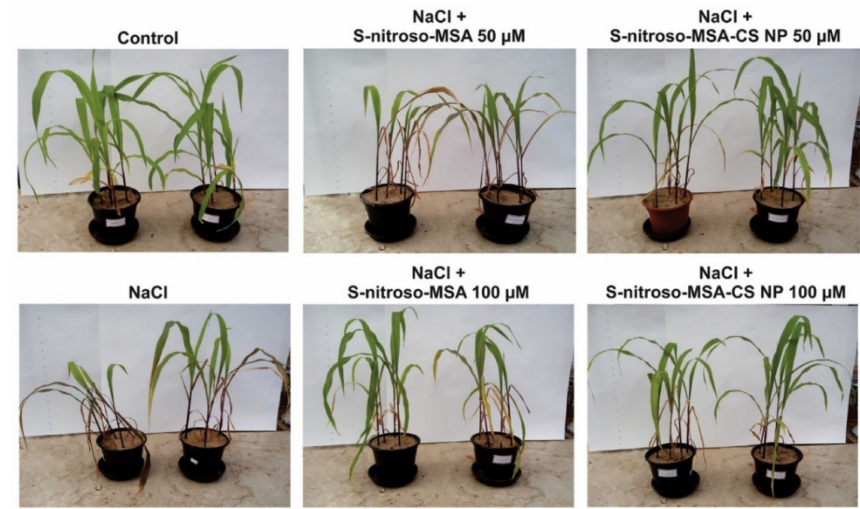
Figure 26. Plants under salt stress and under different treatments [75].